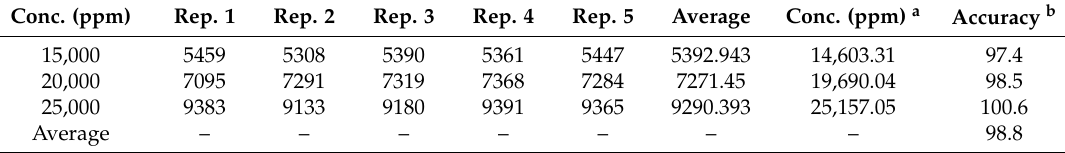
Table 6. Measured peak area of the instrument to different concentrations of ethanedinitrile to determine accuracy of the method.